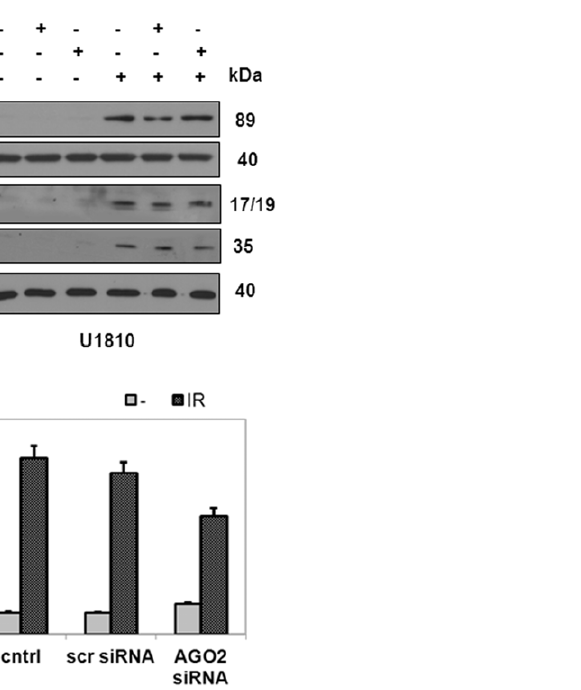
Figure 4. Depletion of a component of the RNA-induced silencing complex (RISC), Argonaute2, does not affect the radioresistance of NSCLC. (A) The level of Argonaute2 (AGO2) mRNA in U1810 cells transfected with control (scram) or AGO2 siRNA normalized against 18S ribosomal RNA. Results are the mean 6 S.E.M. of three independent experiments. (B) Cleavage of PARP and processing of caspase-3 and -9 in U1810 cells transfected (48 h) with control (si scr) or AGO2 siRNA, and then subjected to irradiation for 48 h. Equal loading was verified using anti-GAPDH antibodies. All data are representative of three independent experiments. (C) Detection of apoptotic cell death in U1810 cells after transfection (48 h) with control or AGO2 siRNA and subsequent treatment with irradiation (48 h). (D) Caspase-3-like activity (fold increase with respect to control) in U1810 cells after treatment with either irradiation alone or in combination with transfection with control or AGO2 siRNA. All results shown are the mean 6 S.E.M. of three independent experiments.